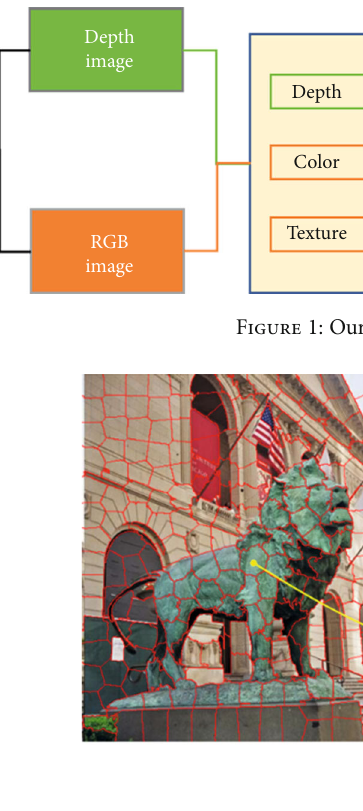
Figure 2: Example of the ACSD operator in a